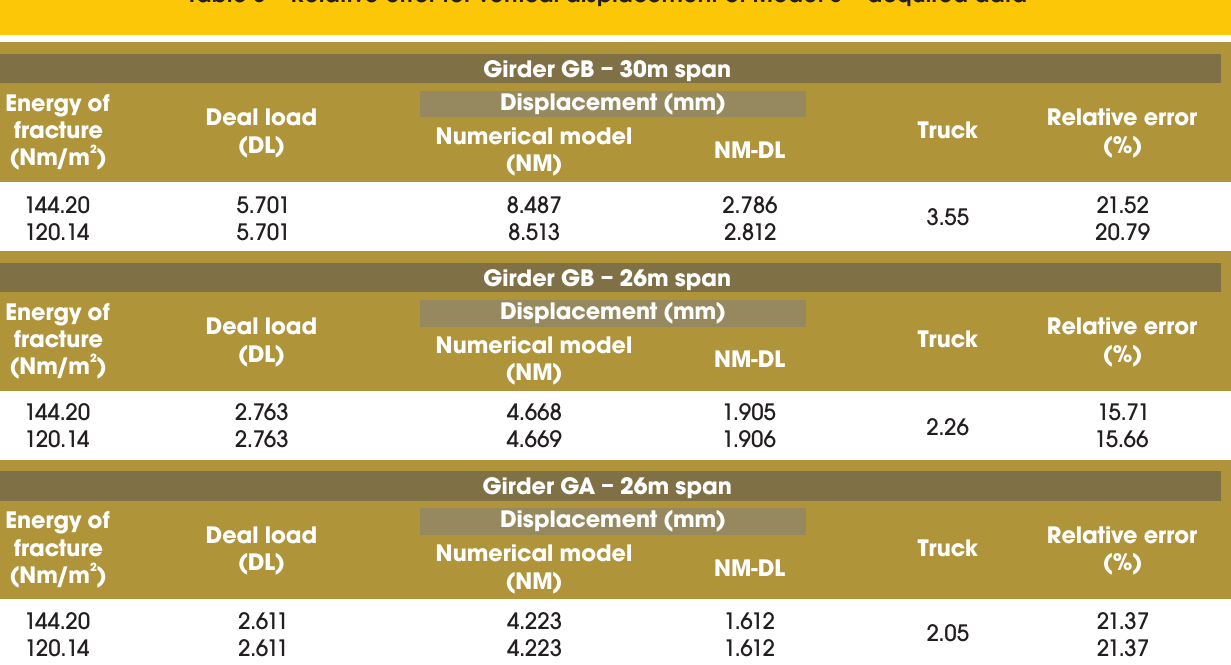
Table 5 – Relative error for vertical displacement of Model 6 – acquired